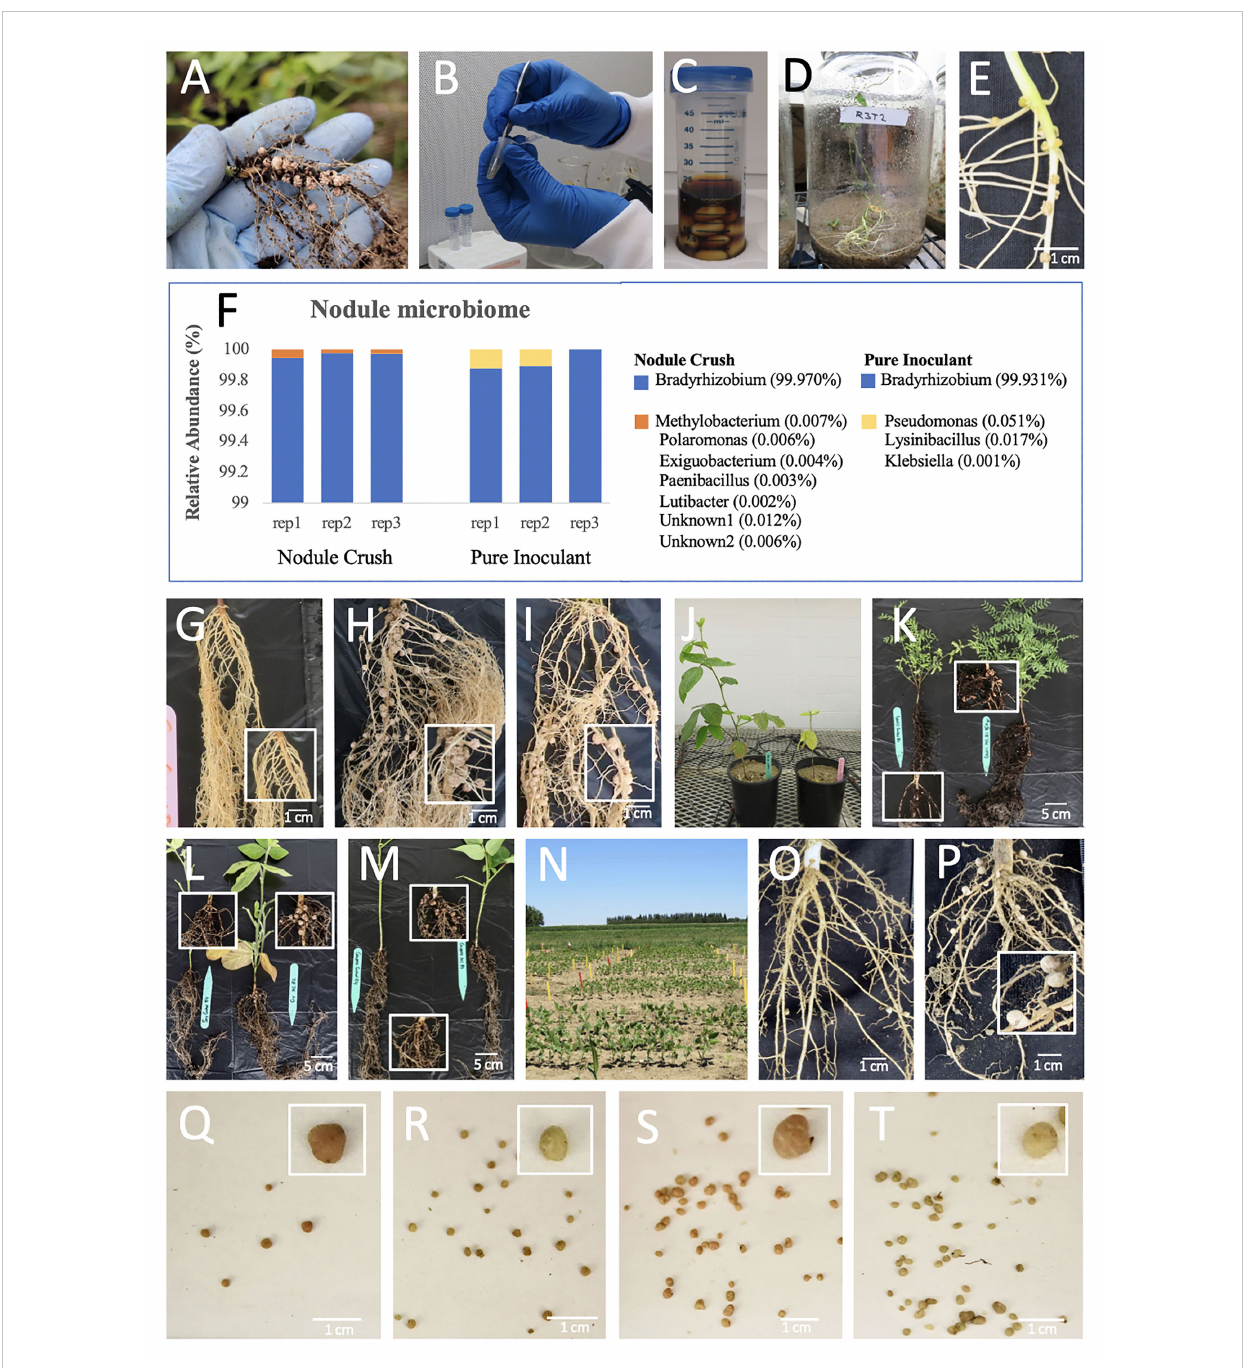
FIGURE 1 Effectiveness of nodule crushing onto seeds to transfer nitrogen- fi xing rhizobia. (A-E) The nodule crushing technique: (A) Example of donor root nodules (cowpea). (B) Crushing soy nodules. (C) Incubating crushed nodule extract with seeds using a sticky agent (e.g. molasses). (D) Closed, sterile jar to demonstrate that future nodules solely originate from crushed nodules. (E) Resulting soy nodules in a closed jar following nodule crushing. (F) Soybean nodule microbiome, showing transfer of rhizobia by nodule crushing is equally effective as pure inoculant. (G – J) Soybean roots grown on sterilized sand, after seeds were treated with: (G) buffer (negative control), (H) nodule crushing, (I) pure inoculant (positive control). (J) Plants derived from seeds treated with nodule-crushing (left) versus buffer (right) on sand. (K – M) Whole plants grown on commercial soil in pots derived from seeds treated with buffer coating (left) versus nodule crushing (right) for: (K) lentil, (L) soybean and (M) cowpea. (N – T) Nodule crushing experiments in fi eld-grown cowpea (Elora, Canada): (N) plots; (O, P) roots of plants derived from (O) buffer-coated seeds showing rare nodules and (P) nodule crushing-treated seeds showing increased nodulation; (Q, R) nodules derived from buffer-inoculated seeds showing (Q) few pink nodules (active) compared to (R) non-pink nodules (inactive); (S,T) nodules derived from nodule crushing-treated seeds showing (S) increased pink nodules versus (T) non-pink